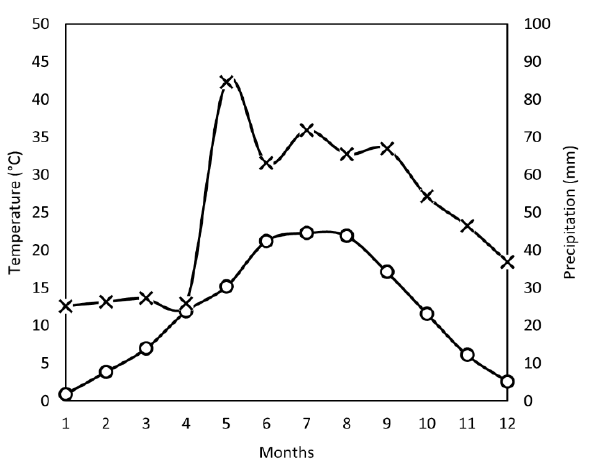
Figure 2. Ombrothermic diagram, which summarizes trends in temperature (O) and precipitation (X) of 6 years of exposure (2016 – 2022). The wet period is typical for the whole year; there is no dry (X) of 6 years of exposure (2016–2022). The wet period is typical for the whole year; there is no period. dry